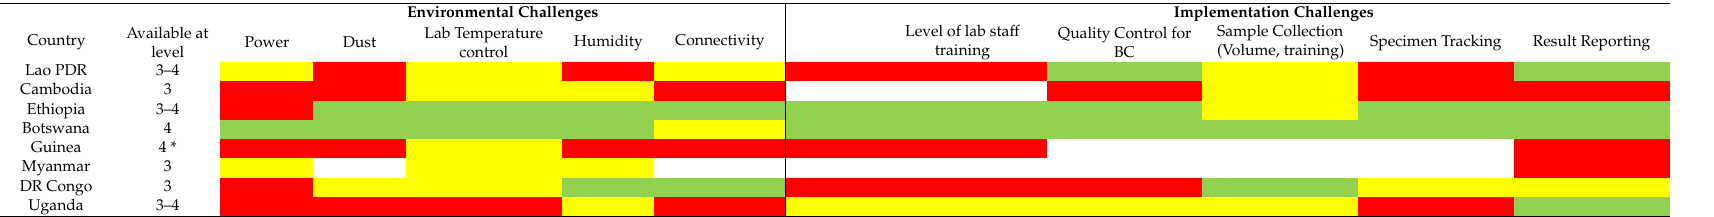
Table 2. Summary of challenges for performing BC in low-resource settings, based on responses from interviewed specialists in multiple countries. Responses were subjective assessments by the interviewed and are not necessarily transferrable to all settings in the respective country. The following definitions for three colors were used: Green = no challenge, yellow = some challenges, red = significant challenges, white = unsure/question not answered. The expertise of the interviewees from the different countries were infectious disease physicians (Lao PDR, Myanmar, Cambodia), public health/clinical microbiologist (Ethiopia, Botswana, Guinea) and clinical researcher (DR